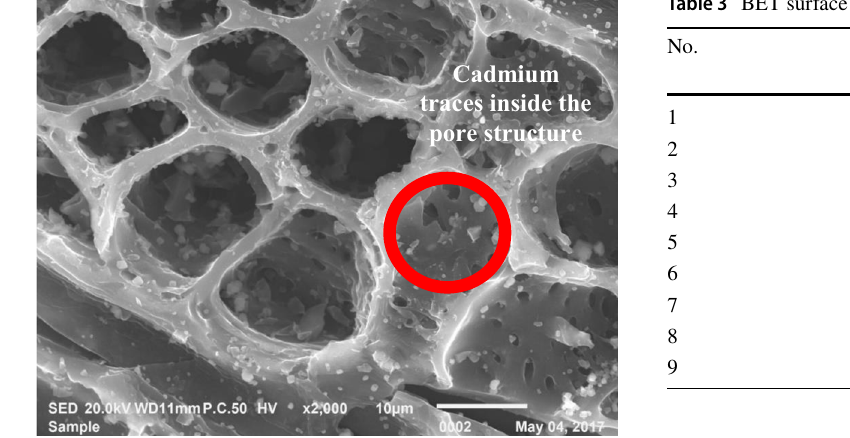
Fig. 2 SEM image of activated carbon after the adsorption process at magnification 2000x